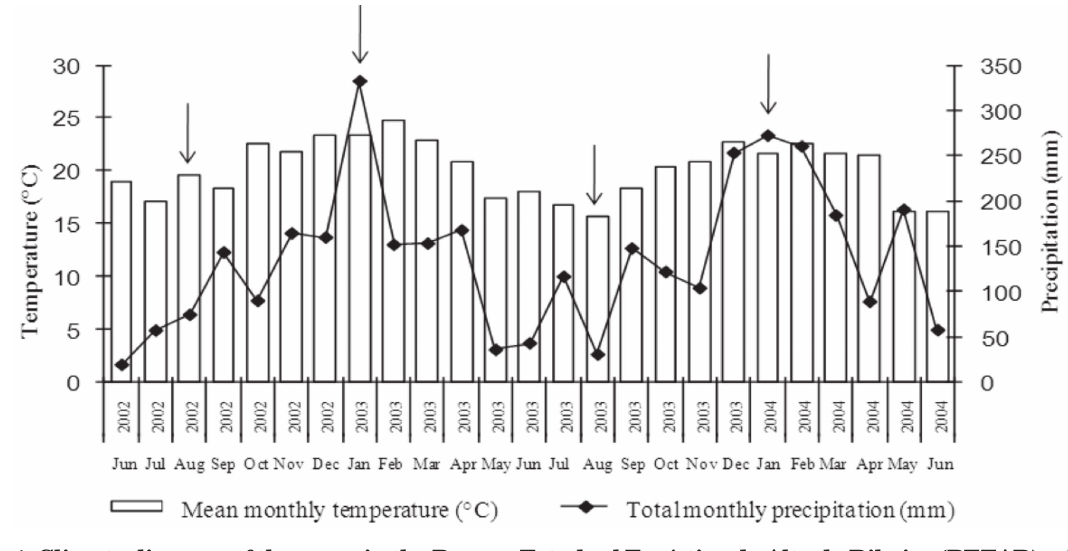
Figure 1. Climate diagram of the areas in the Parque Estadual Turístico do Alto do Ribeira (PETAR) selected for this study. The arrows indicate the sampling months (August 2002, January 2003, August 2003, and January